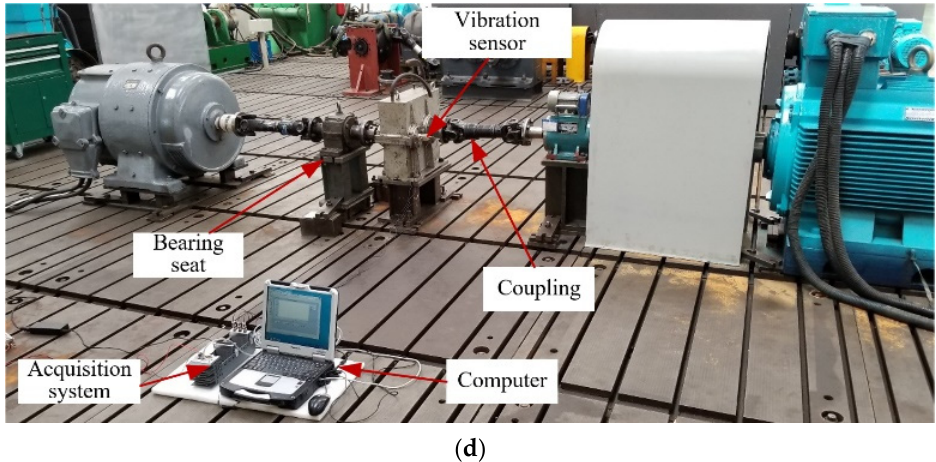
Figure 10. Transmission box failure test system. ( a ) gear transmission box; ( b ) Internal structure of gear transmission box; ( c ) Test equipment composition; ( d ) Test system composition.